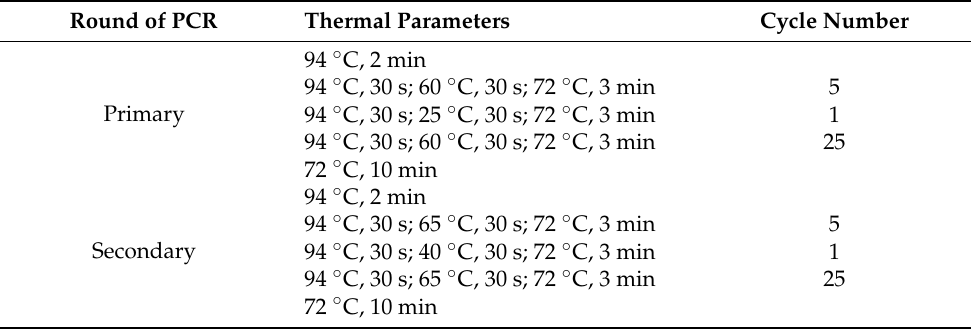
Table 2. Thermal cycling parameters of semi-site-specific primer PCR. Round of PCR Thermal